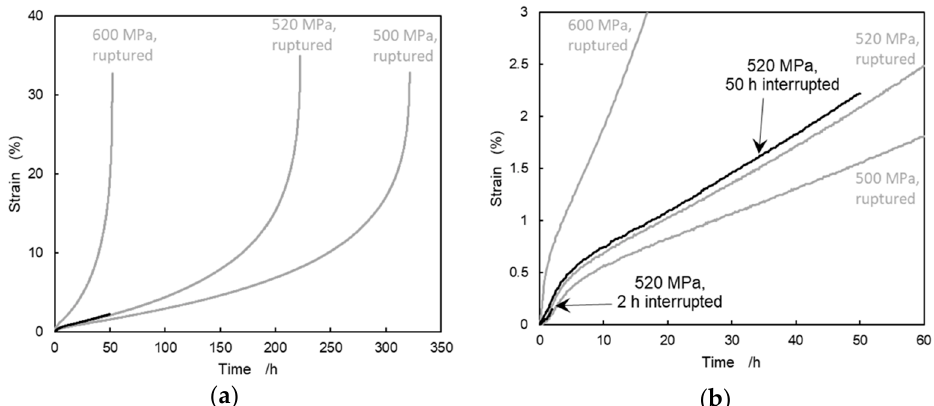
Figure 4. Creep curves at 760 °C. ( a ) Whole region of creep tests, ( b ) early stage of creep tests.